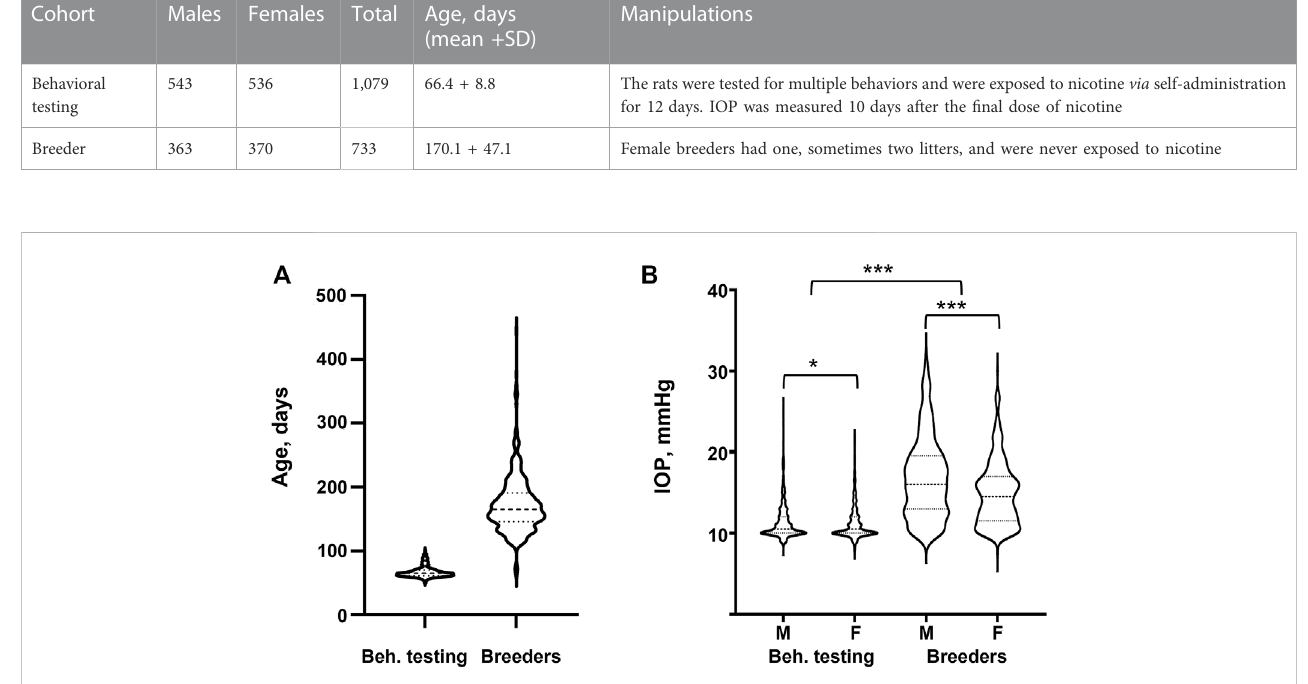
FIGURE 1 IOP in different experimental cohorts. (A) Age distribution for the Behavioral testing (N = 1,079) and Breeder (N = 733) cohorts. (B) IOP values for Behavioral testing and Breeder cohorts separated by sex. Statistical difference between sexes was tested with two-tailed t -test, statistical difference between Behavioral testing and Breeder cohorts was tested with Welch ’ s t -test. *denotes p -value < 0.05, *** denotes p -value <